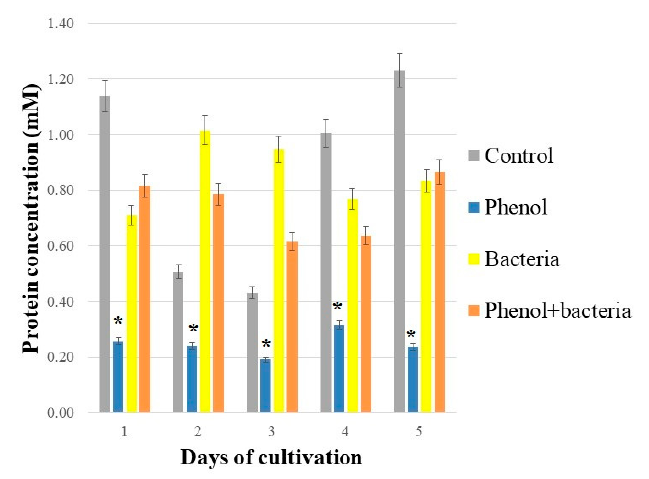
Figure 2. Total soluble proteins of duckweeds cultivated under different experimental conditions: Control—sterile duckweeds cultivated in phenol-free MS medium; Phenol—sterile duckweeds cultivated in phenol-supplemented MS medium; Bacteria—duckweeds inoculated with bacteria H. paralvei and cultivated in phenol-free MS medium; Phenol + bacteria—duckweeds inoculated with bacteria H. paralvei and cultivated in phenol-supplemented MS medium. Concentration of phenol in all experiments was 500 mg L − 1 . Data represent the mean ± SE ( n = 3). * indicates significant dif- ference in treatments at p < 0.05.